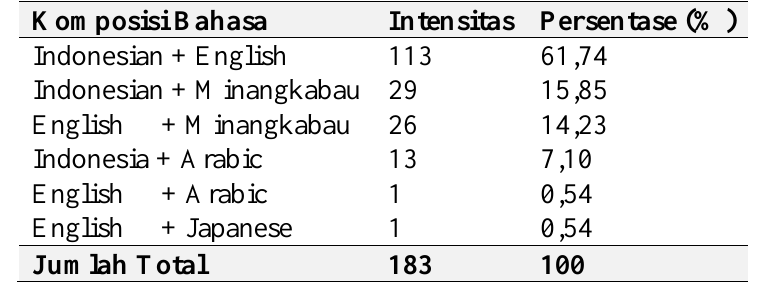
Table 6. The intensity of using bilingual language compositions